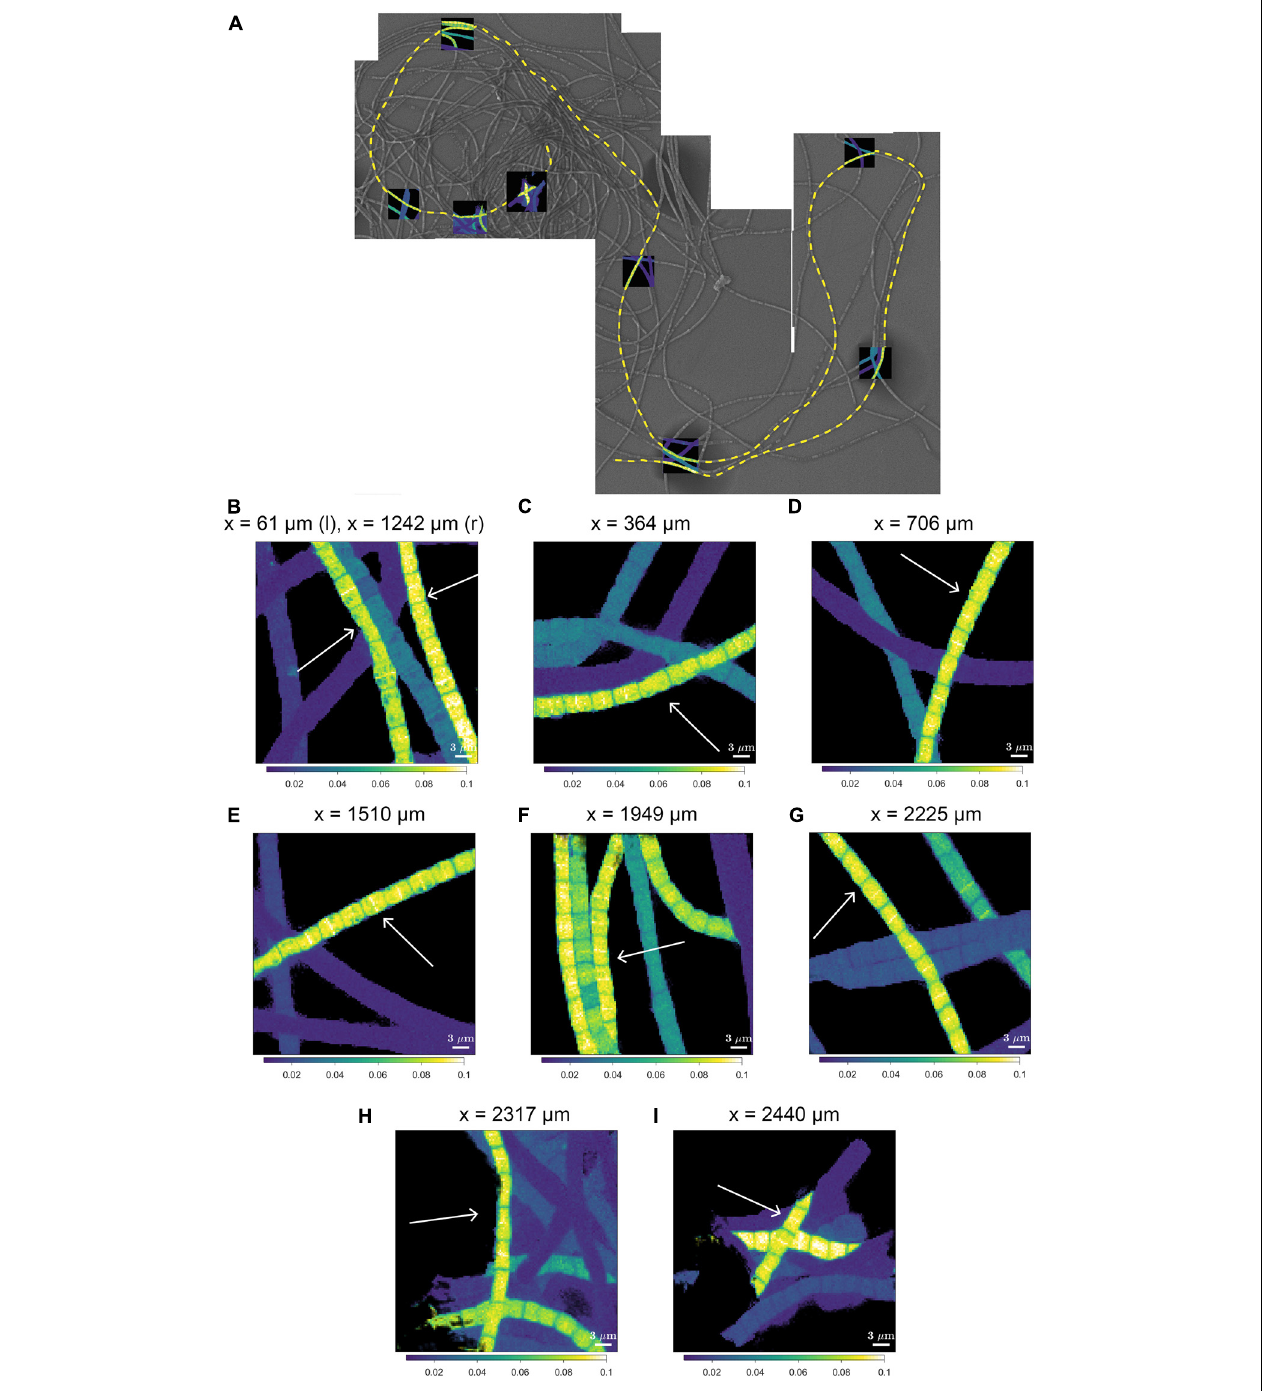
FIGURE 4 | NanoSIMS images of the 13 C atom fraction measured along the length of a filament in the process of cell division. (A) Mosaic image of Scanning Electron Microscopy (SEM) showing a bundle of cable bacterium filaments. The dashed yellow line indicates the filament that was investigated in detail with nanoSIMS (filament #20). NanoSIMS images of the 13 C atom fraction [calculated as 13 C/( 12 C + 13 C)] are superimposed onto the SEM image. The corresponding 15 N atom fractions can be found in Supplementary Figure 1 . (B–I) Detailed nanoSIMS images of the 13 C atom fraction measured in certain segments along the filament. White arrows indicate the segments of the filament that has been analyzed. The distance x (as measured from the start of the filament) is indicated on top of each image. Scale bars are all 3 µ m. NanoSIMS images of the 13 C atom fractions of all the 20 other measured filaments can be found in Supplementary Figure 2 .